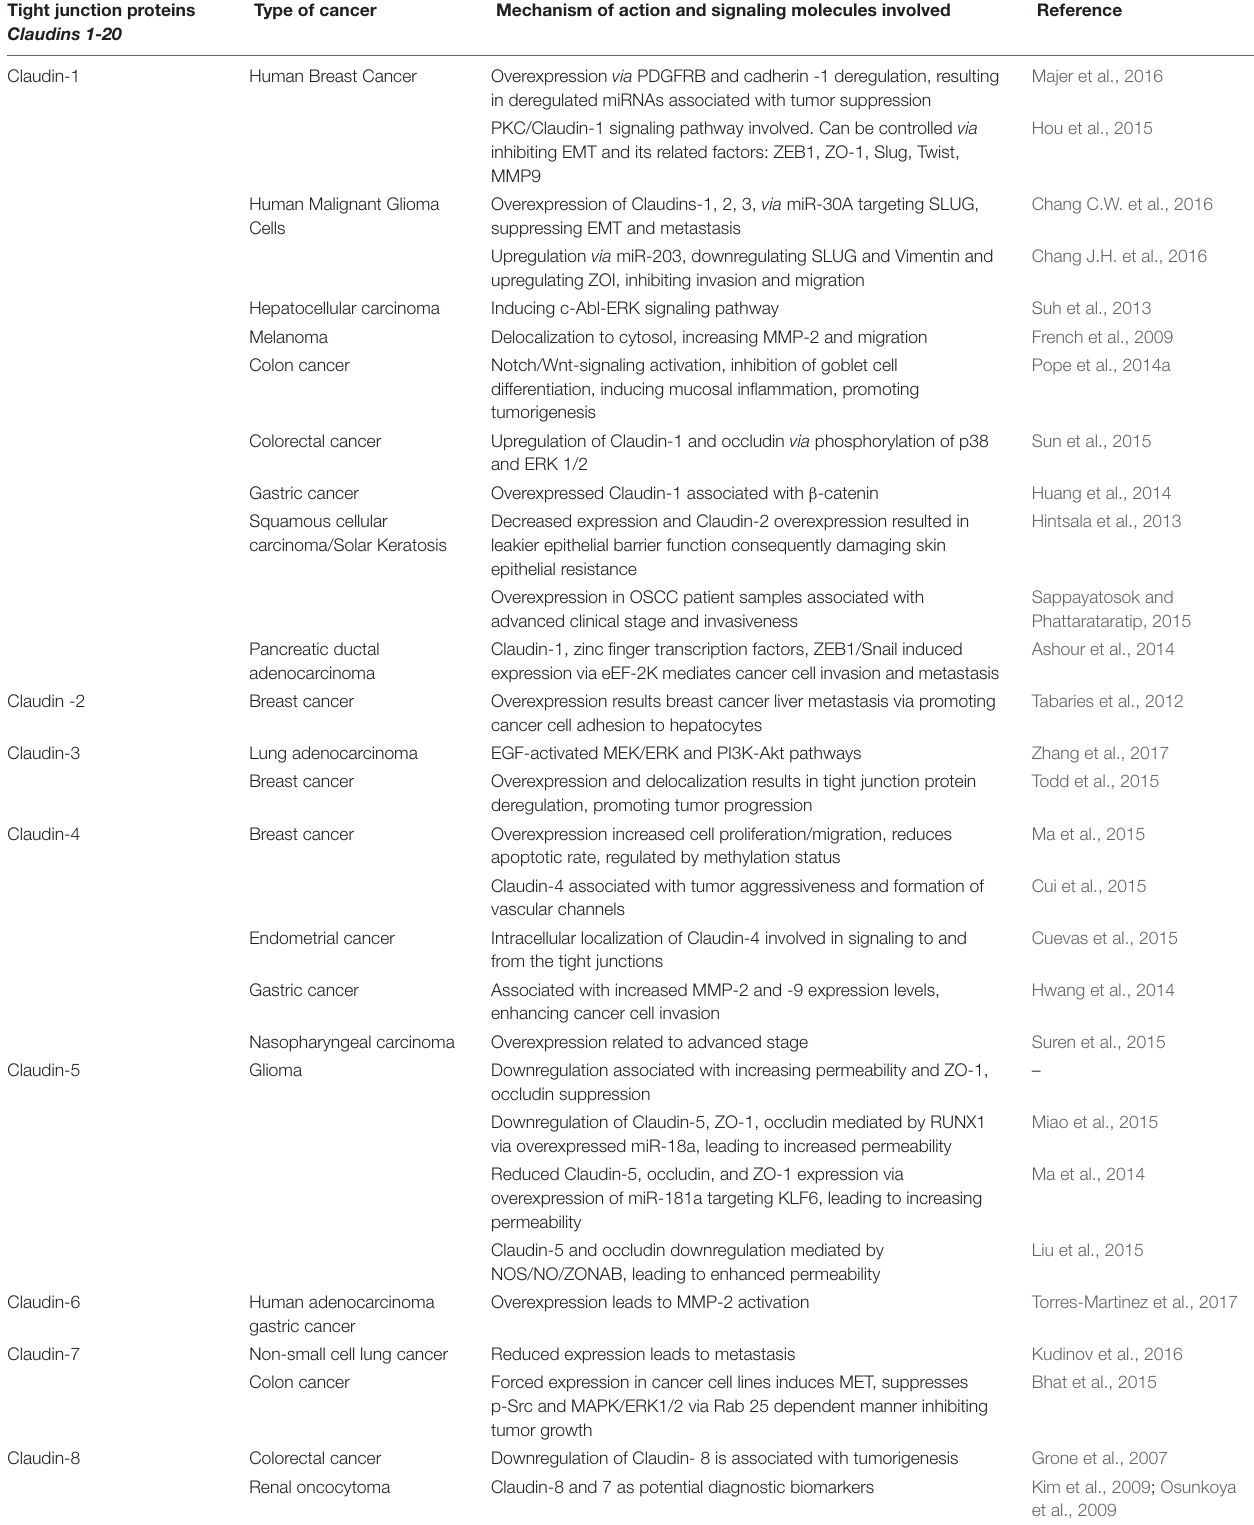
TABLE 1 | Dysregulated claudins in various cancers, crosstalk and the